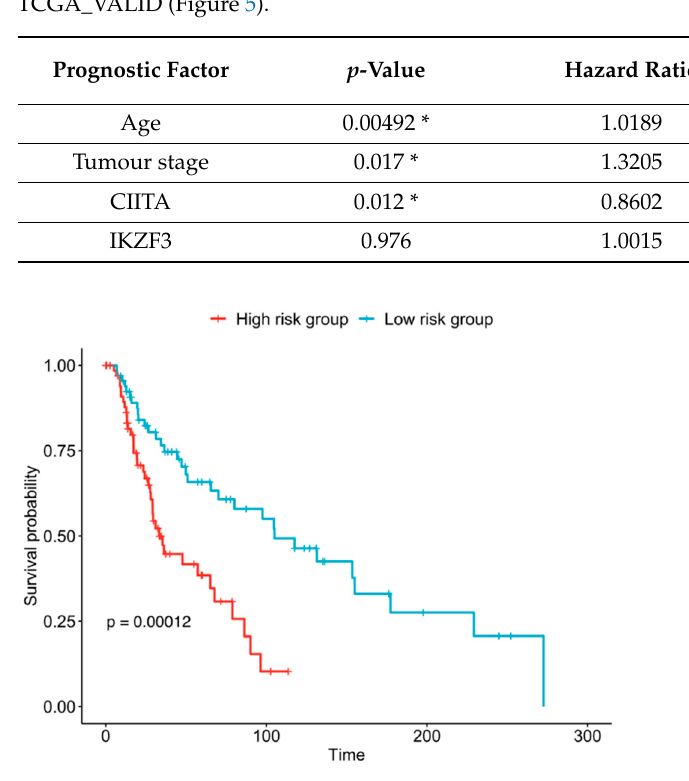
Table 4. Cox proportional hazards model for overall survival in the training data (TCGA_TRAIN, n = 255). Asterisks (*) indicates p -value < 0.05. This model was taken forwards for validation in TCGA_VALID (Figure 5).